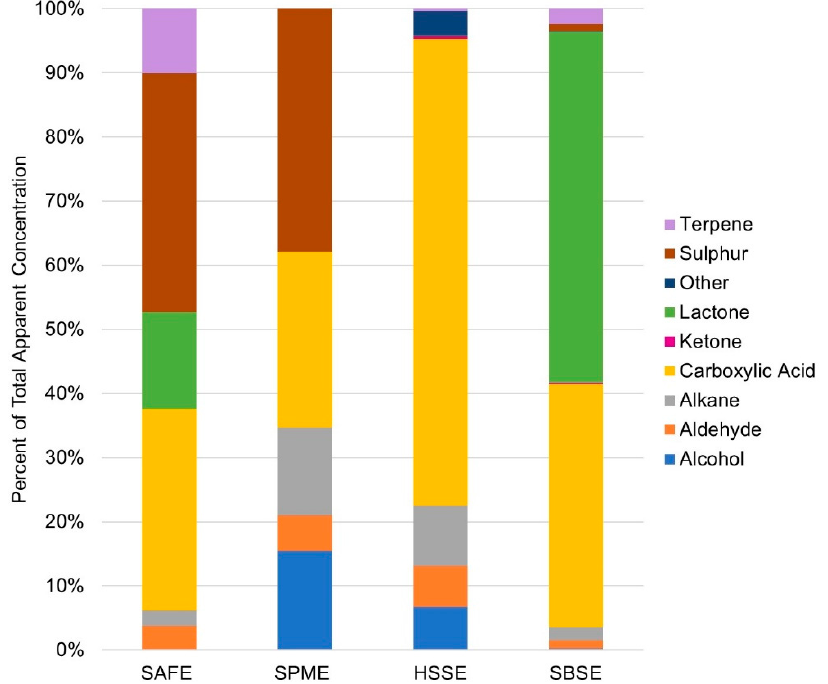
Figure 1. The percentage distribution of volatile compounds in each compound class detected in sheep milk by Solvent Assisted Flavour Evaporation (SAFE), Solid Phase Microextraction (SPME), Headspace Sorptive Extraction (HSSE) and Stir Bar Sorptive Extraction (SBSE).